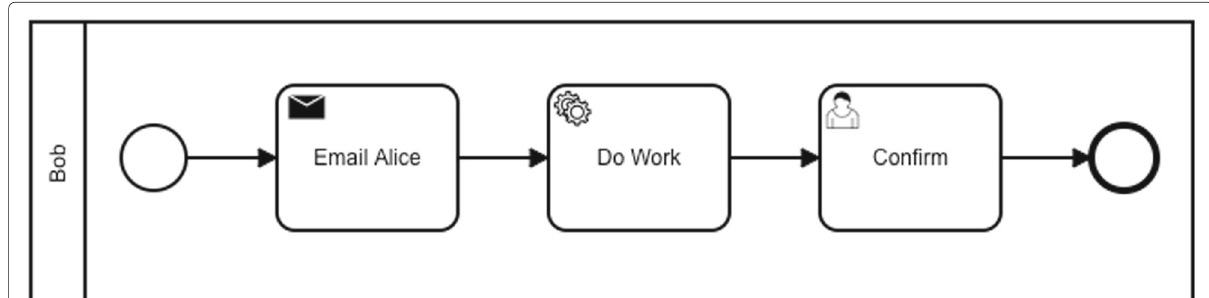
from regular discussions with the provider about the assets, threats and risks, his interaction with the service is limited to receiving alerts and instructions, and filling out